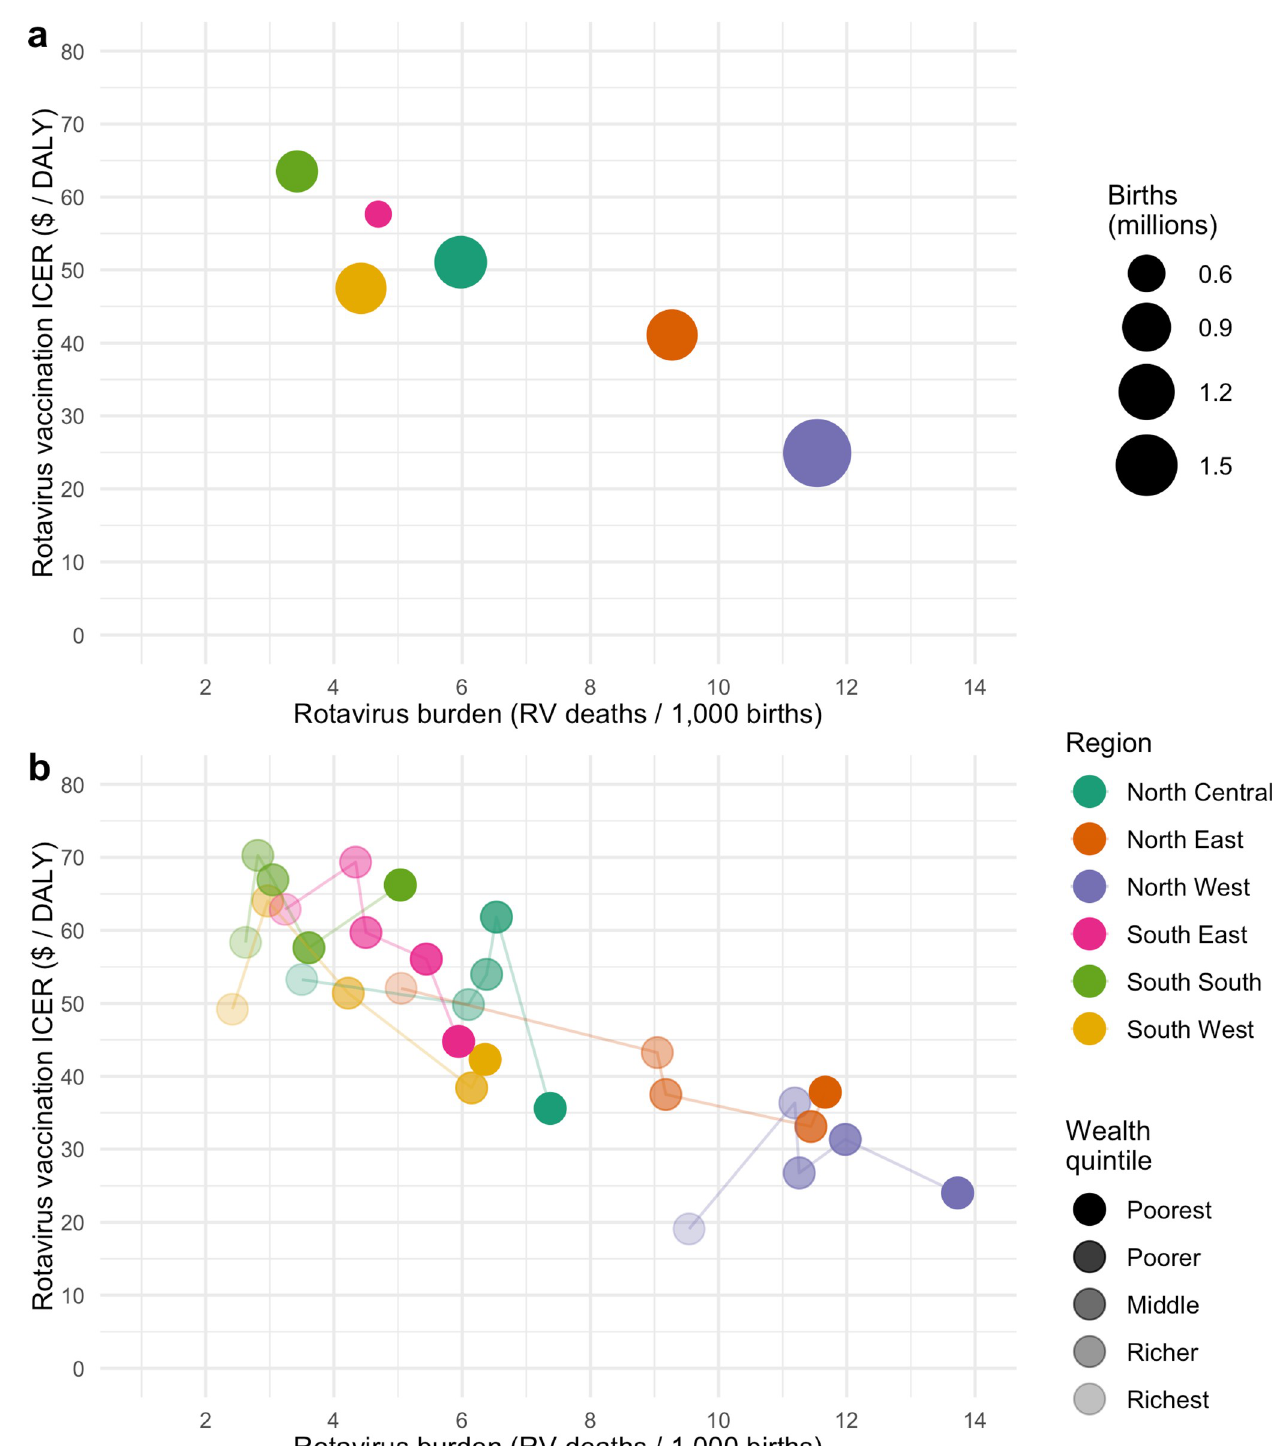
Fig 4. Estimated incremental cost-effectiveness ratios (ICERs) for rotavirus vaccination by rotavirus mortality burden for each region (a) and wealth quintile (b) subpopulation.